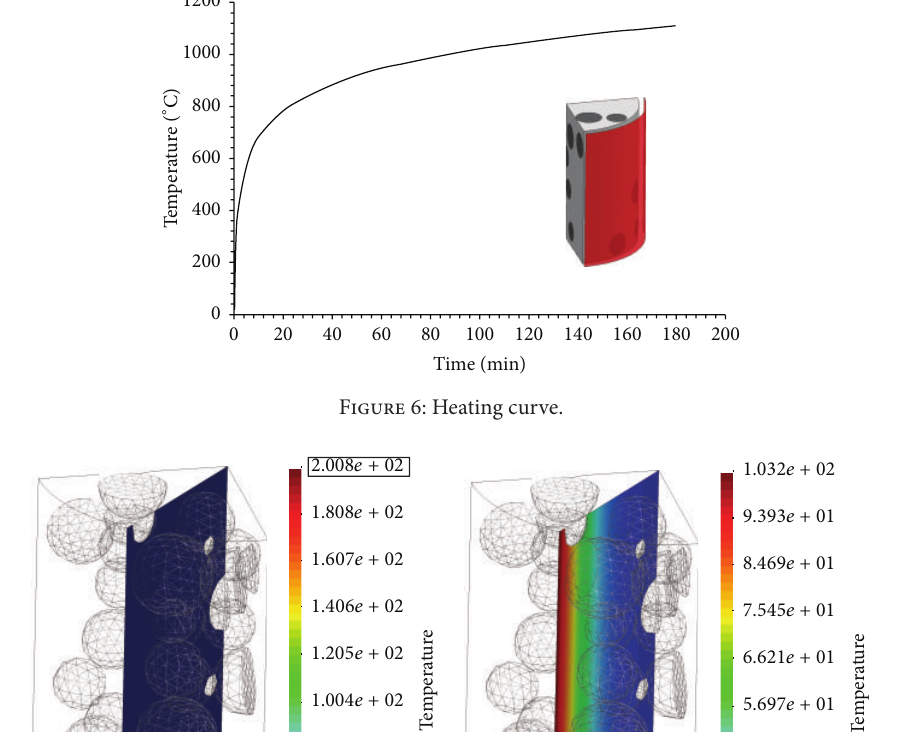
Considering the same thermal conductivity and specific heat for the cement matrix and the aggregates, the thermal distribution inside the sample during the analysis is not affected by the different components, as visible in Figure 7.